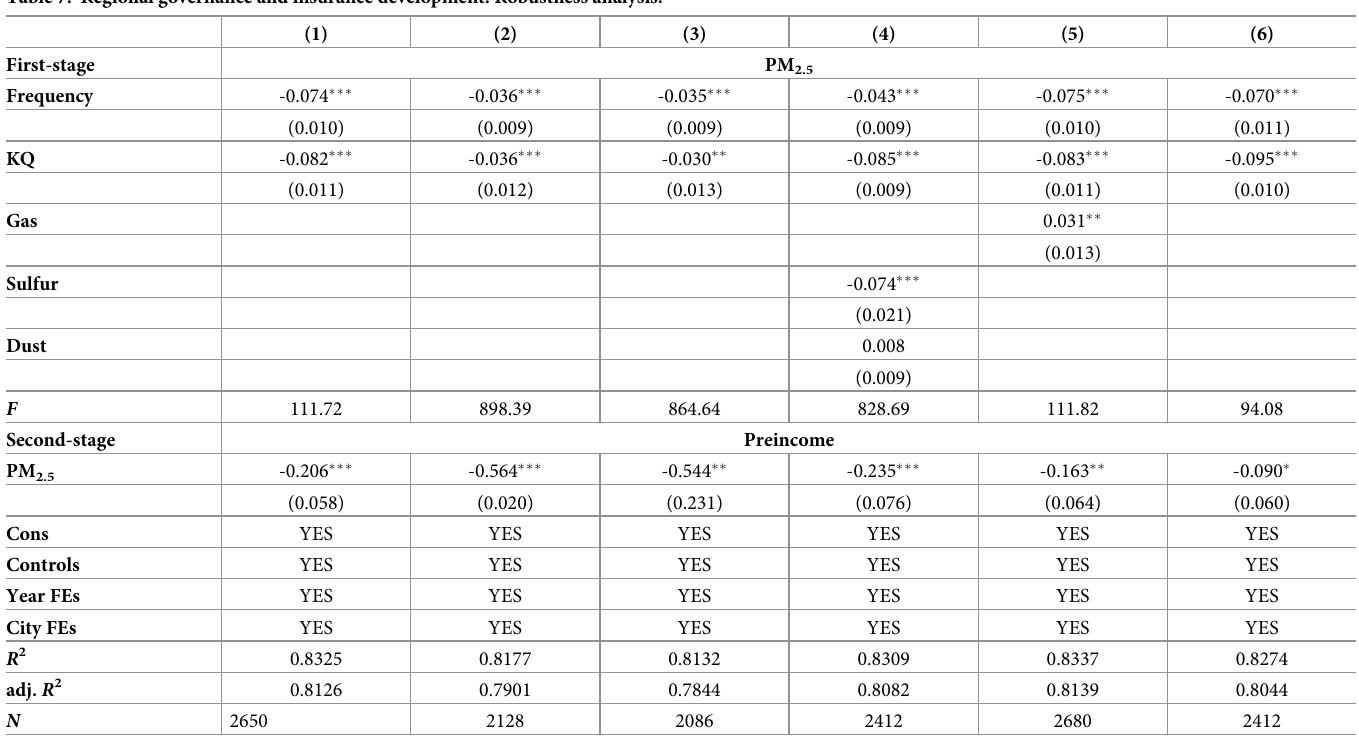
Table 7. Regional governance and insurance development: Robustness